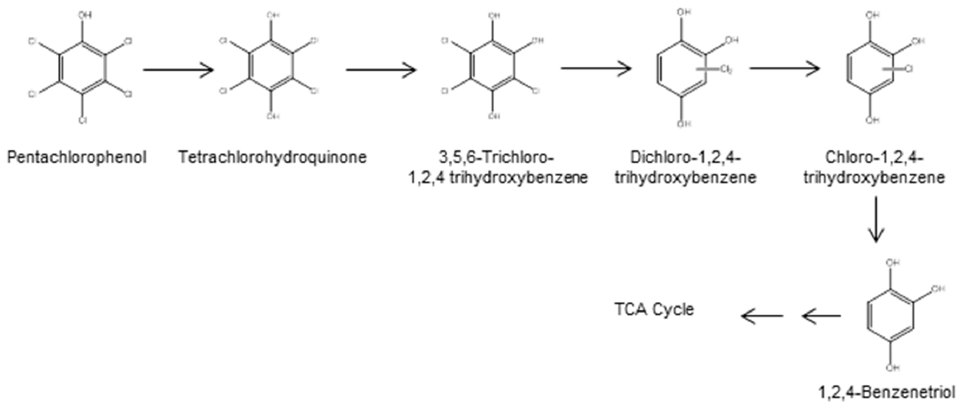
Figure 2. Bacterial degradation pathway of PCP in Mycobacterium strains [17,30,32].